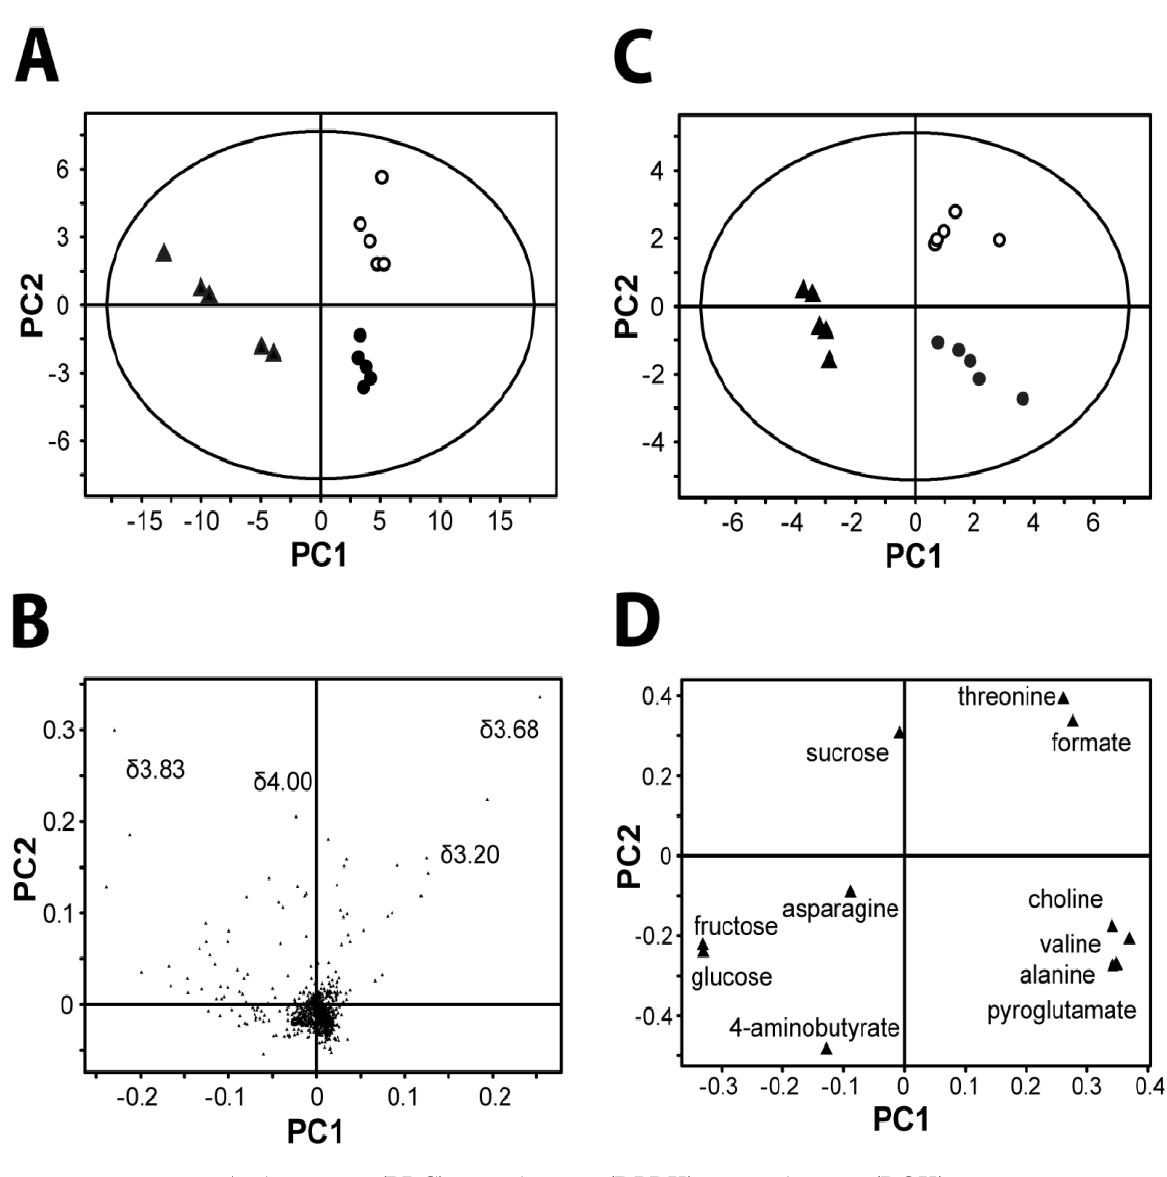
Figure 2. Chemometric analysis by principle component analysis (PCA). ( A ) and ( B ): Score and loading plots from pattern recognition (PCA) of whole 1 H-NMR spectra are shown. The data sets are Pareto -scaled. Overall, discrimination of all three groups of Angelica ( n = 5) was clearly shown in the score plot. The loading plot shows that 3.2–4 ppm, the sugar region, is the most discriminating feature. (PC1: R2 = 0.70, Q2 = 0.63; PC2: R2 = 0.86, Q2 = 0.78) ( C ) and ( D ): Scores and loading plots from pattern recognition (PCA) of a selection of targeted molecules. Data are unit-variance scaled. Loading plot shows which molecules contributed most to the discrimination. (PC1: R2 = 0.56, Q2 = 0.34; PC2: R2 = 0.74, Q2 = 0.36). Abbreviation: PRC, A. sinensis from China; DPRK, A. gigas from Democratic People’s Republic of Korea; ROK, A. gigas from Republic of